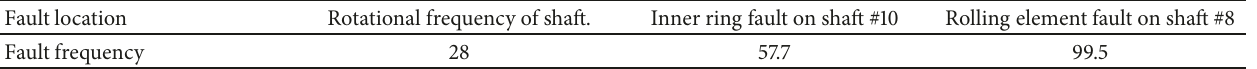
Table 7: Fault information.